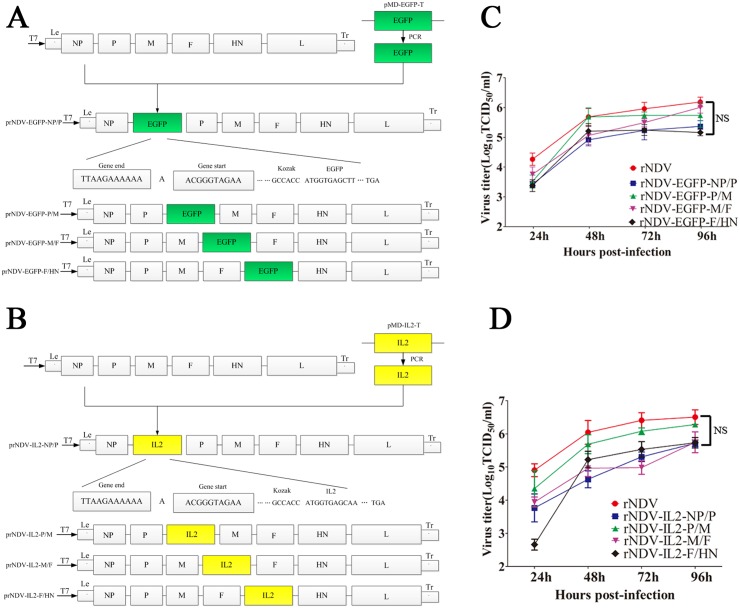
Scheme of the different rNDVs expressing EGFP (A) or IL2 (B) proteins.The small cassette which includes GS, GE, Kozak sequence, and EGFP or IL2 gene was inserted in different intergenic regions in the rNDV genome. The effects of inserted foreign genes on the proliferation of rNDV-EGFPs (C) and rNDV-IL2s (D). Ten-day-old embryonated eggs were inoculated with 100 PFU of the indicated rNDV, and llantoic fluids were harvested at 96 hpi. rNDV titers on DF-1 cells were determined by measuring TCID50 and expressed as log10 TCID50/mL from three independent experiments (NS: nonsignificant).